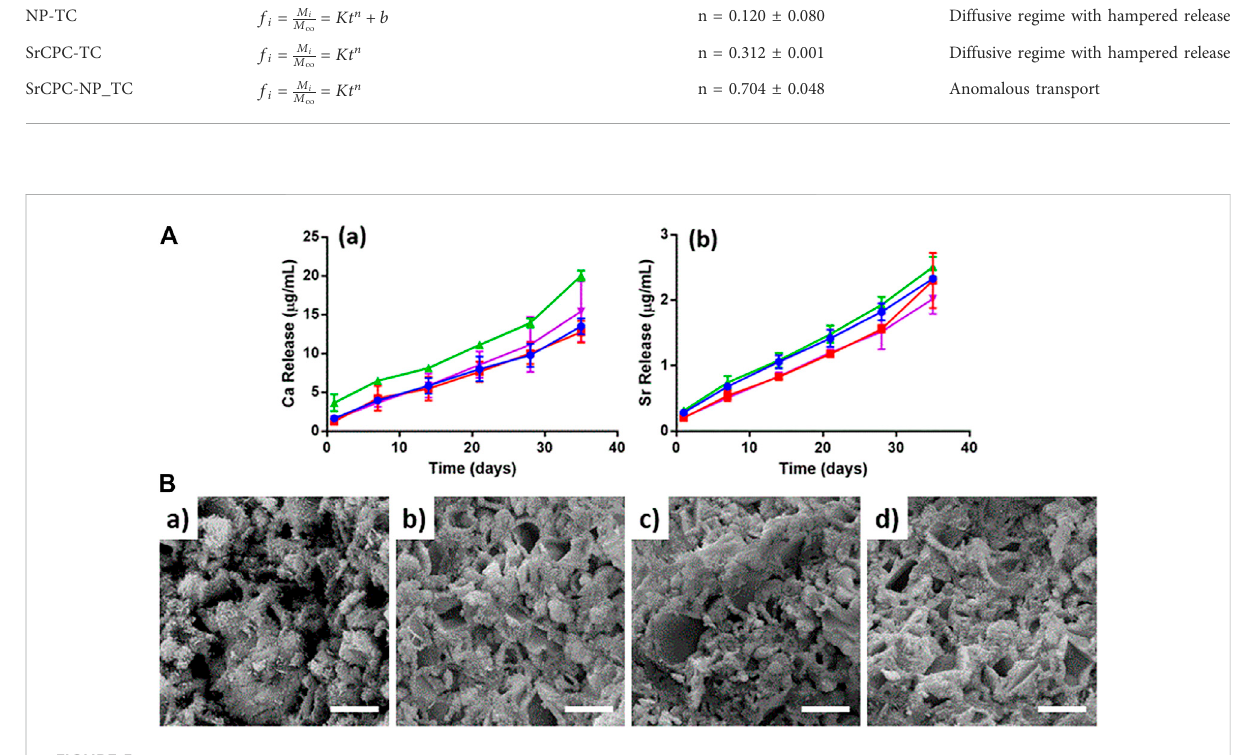
TABLE 1 Different values for n exponent of Korsmeyer-Peppas model obtained by fi tting our empirical data, associated to the corresponding release regime. Samples